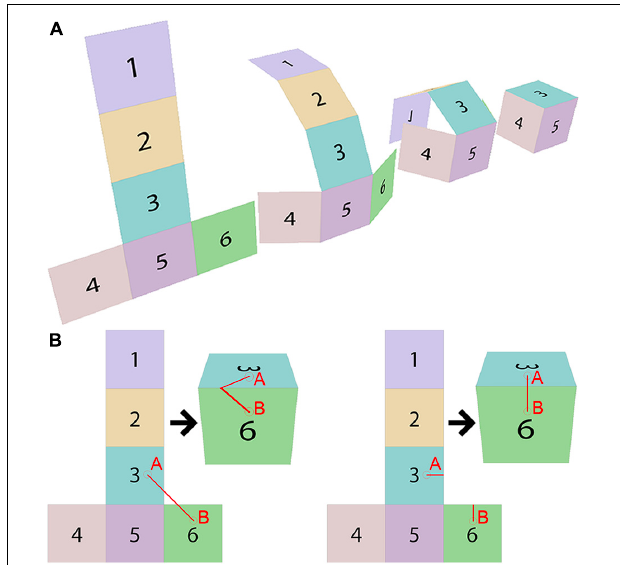
FIGURE 2 | Rendering pipeline techniques. (A) The mapping from 2D texture space to 3D mesh space via a predefined mapping. (B) A naïve, left, and correct, right, implementation of a 3D painting algorithm. This figure illustrates how a straight line in 2D texture space does not result in a straight line in 3D mesh space, making the development of a 3D painting and labeling tool non-trivial. Each square on the cube is given a color and number to highlight how the forms turn in 3D